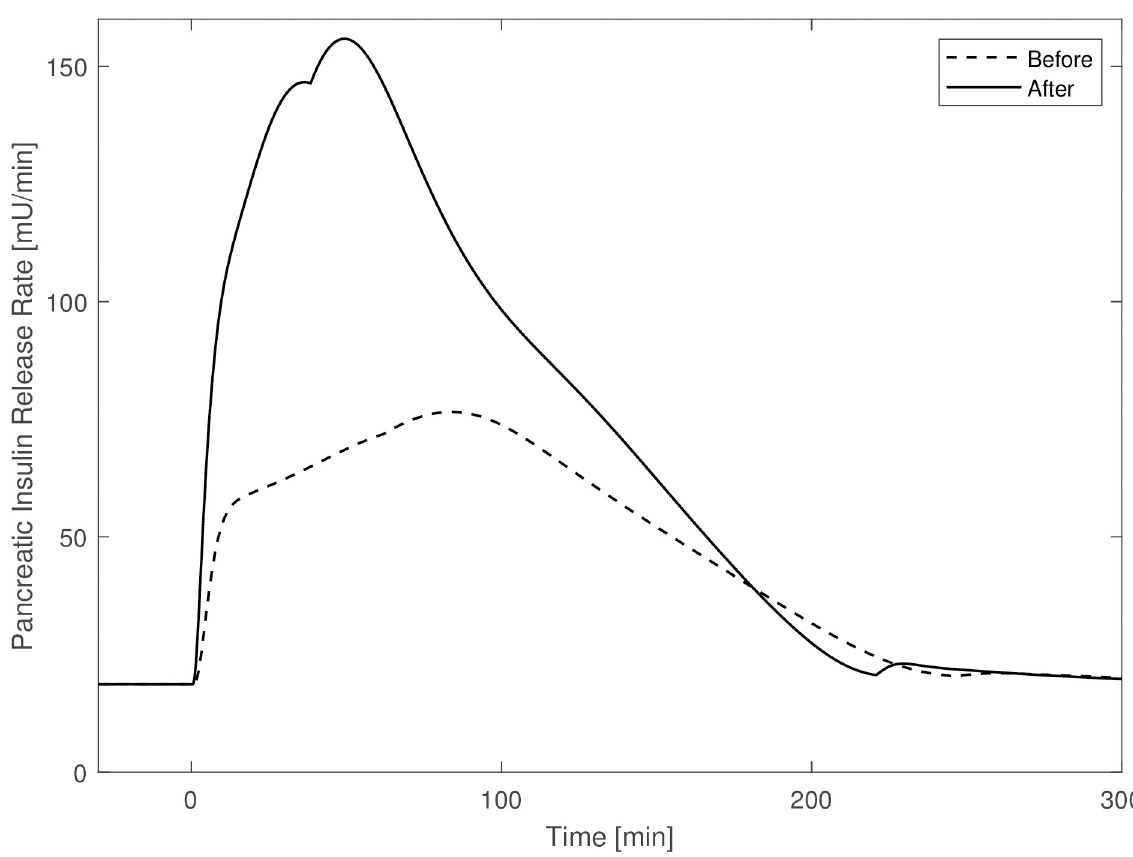
Fig 5. Pancreatic insulin release rate before against after. Pancreatic insulin release rate time courses obtained with parameters set at their original values (dashed line) and with parameter values from STEP 3 (continuous line).